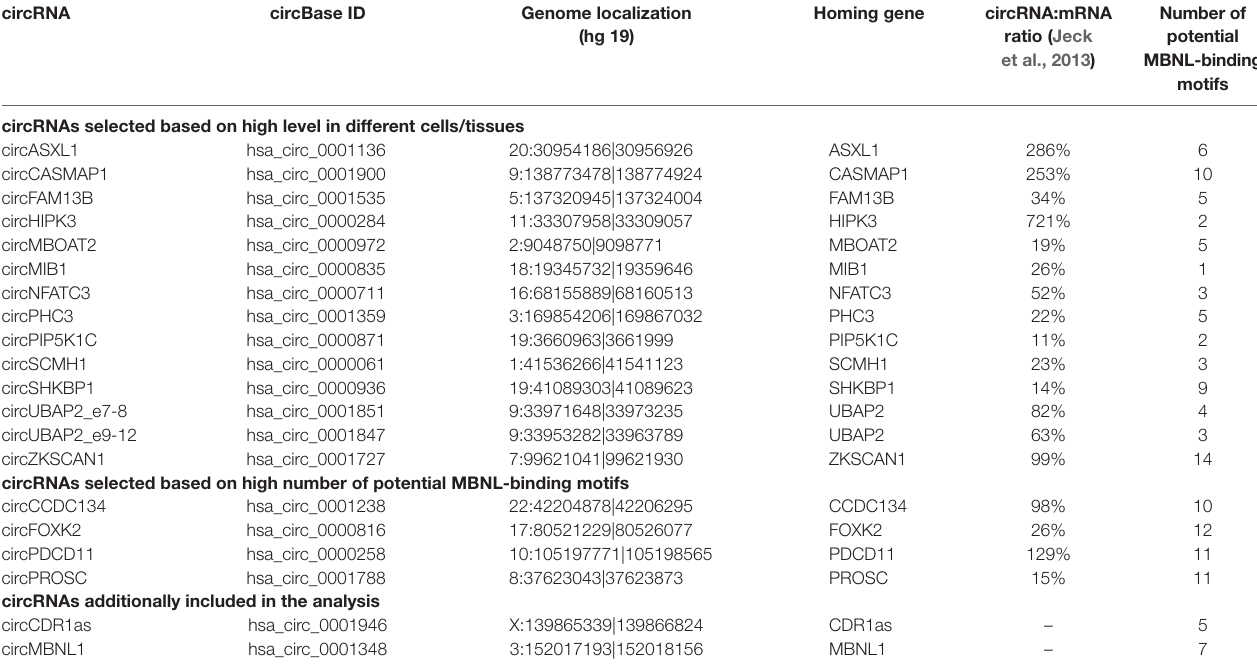
TABLE 2 | CircRNAs selected for